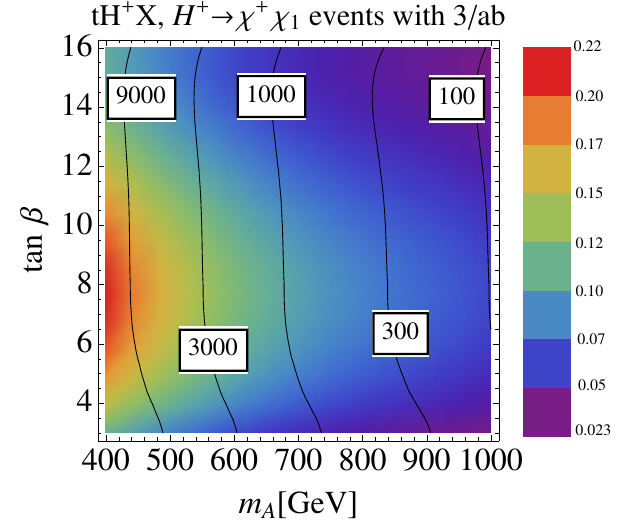
Figure 14 . The number of events for pp ! tH (cid:6) X; H (cid:6) ! (cid:31) (cid:6) (cid:31) 1 at the HL-LHC. This plot uses the same mass spectrum as of (cid:12)gure 3 (left panel): in particular, M 1 = 150 GeV and (cid:22) = m A (cid:0) 175 GeV. The color coding denotes the branching ratio BR( H + ! (cid:31) + (cid:31) 1 ).